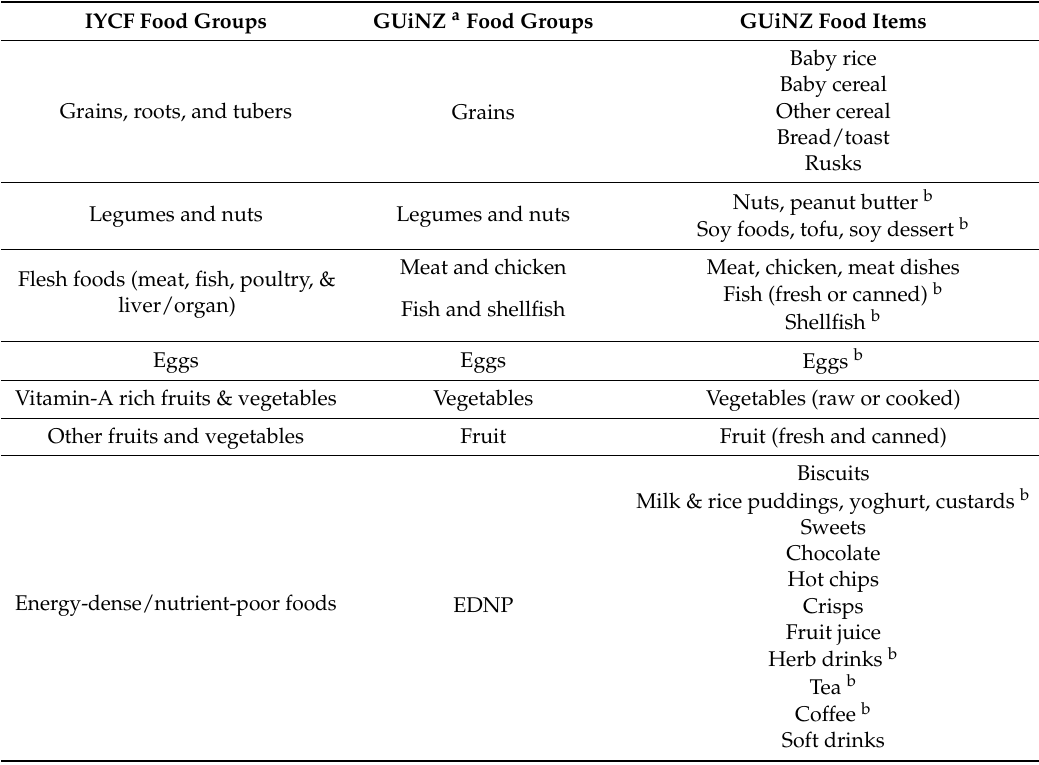
Table 1. Food items and food groups created from the Growing Up in New Zealand study as